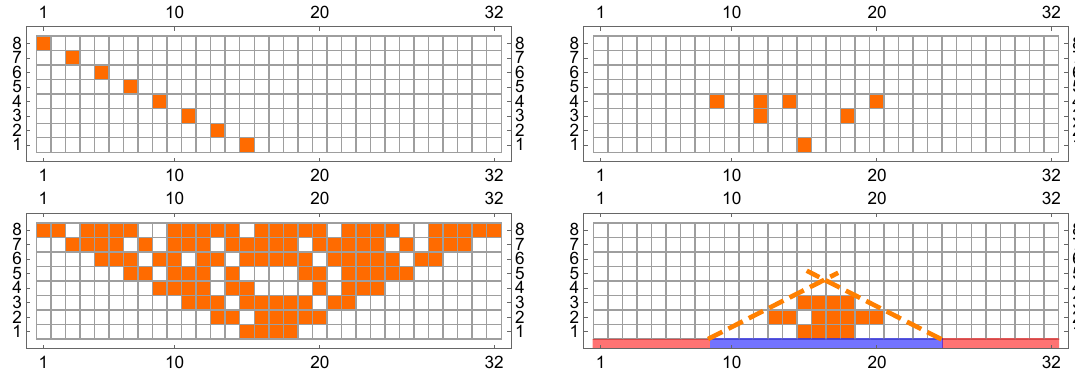
Figure 25 . The causal future of a link at t = 0 (pointing to the upper left in the center of the lowest layer) is colored orange. In particular, the orange points are individually causally influenced by the link at the initial time. The vertical axis is time and the horizontal axis is space (links) with periodic boundaries. Top-left: the integrable swap code with a random stabilizer initial state; top-right: the perfect [[4,0,3]] qutrit code with the same initial state; bottom-left: the same perfect code with initial state 0 0 ; bottom-right: the same perfect code with an infinite temperature | (cid:30)(cid:29) | initial state in the region marked red and 0 0 marked blue. Dashed lines are visual guides for (cid:31) | (cid:30)(cid:29) | the light cones of the red (cid:31)